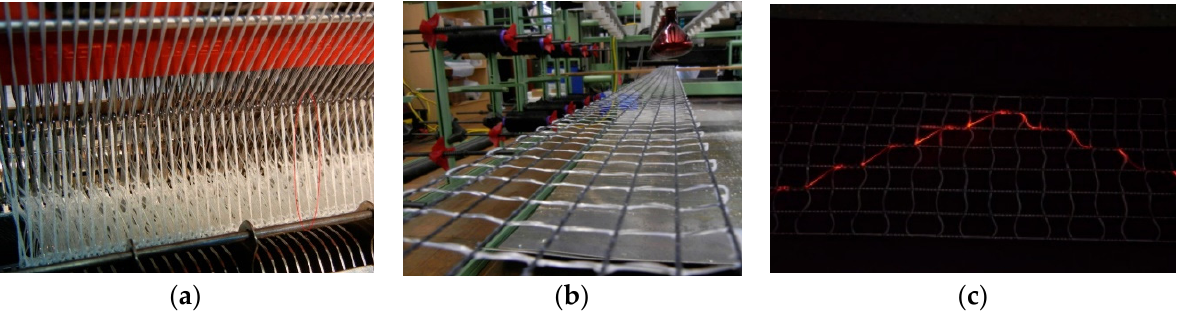
Figure 14. Fabrication of TNS: warp knitting machine ( a ), fabricated biaxial grids consisting of alkaline-resistant glass multifilament and a polypropylene multifilament thread ( b ), and the TNS with integrated optical glass fiber ( c ). Reprinted with permission from ref. [51]. Copyright 2016 Procedia Technology.